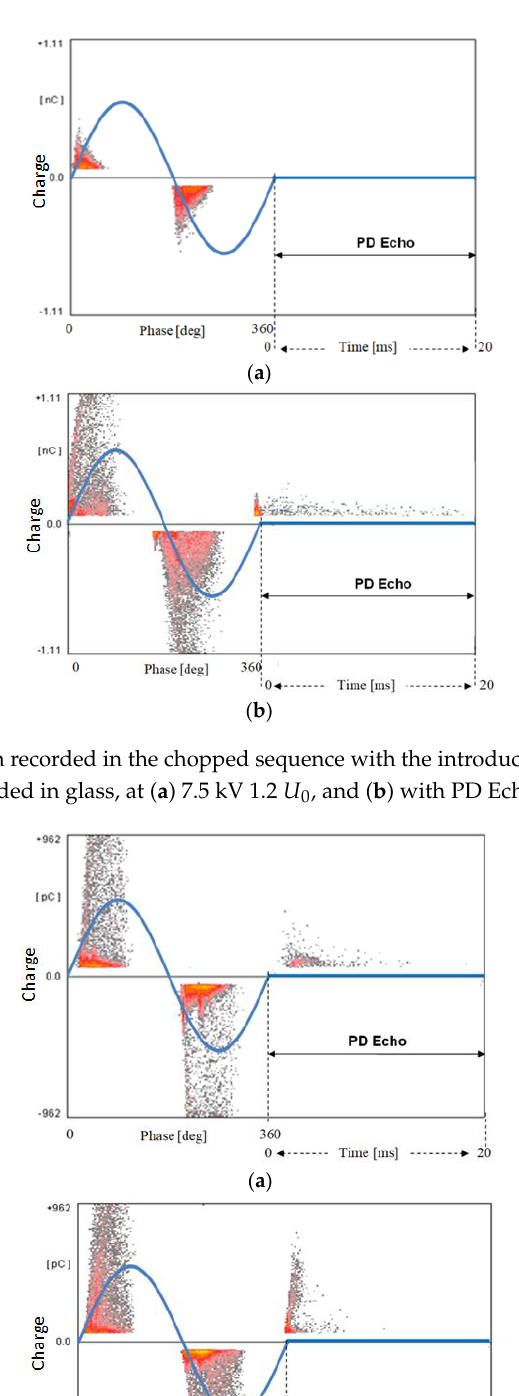
0 , and ( b ) at 15kV 2.4 U 0